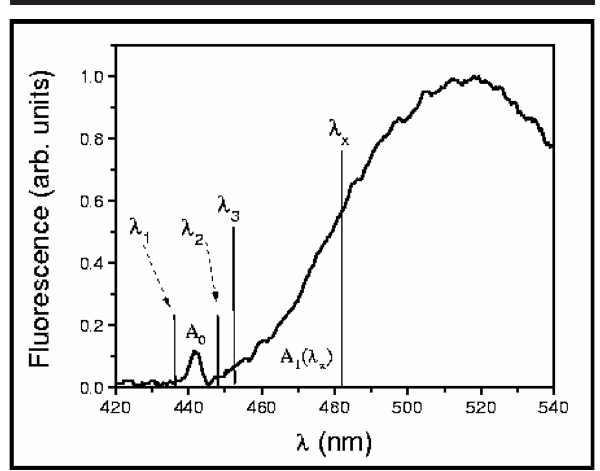
FIGURE 4 - Typical fluorescence spectrum with all the parameters involved in the calculus of FM.